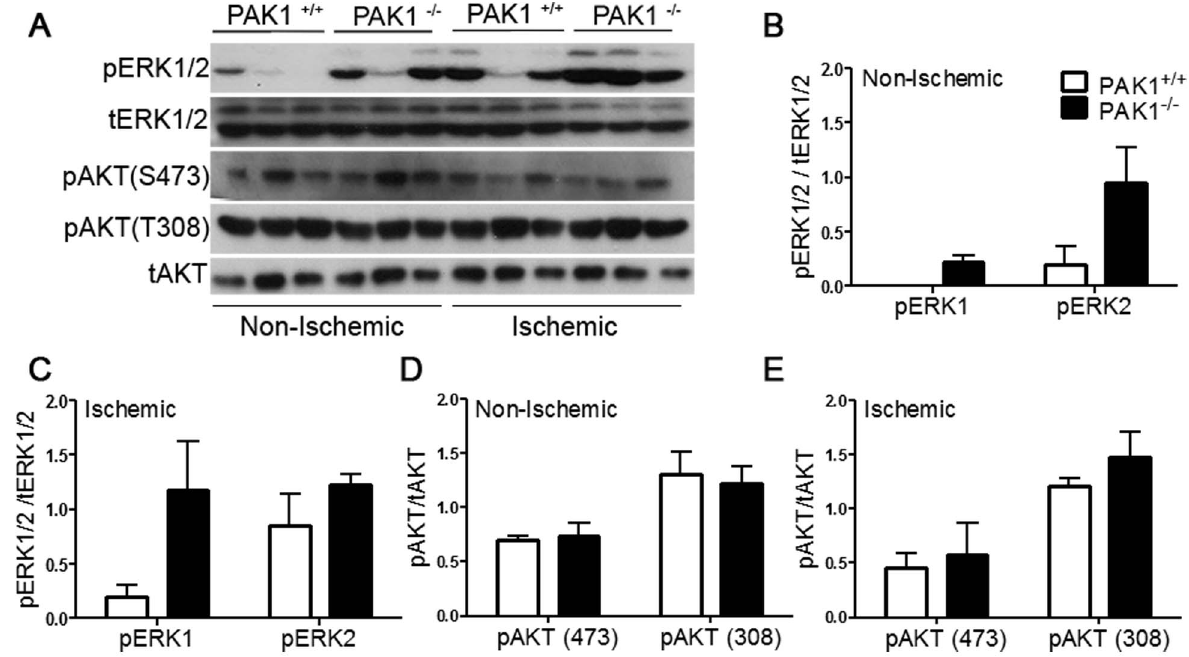
Figure 4. A) A notable activation of ERK1/2 but not AKT is observed in PAK1 2 / 2 gastrocnemius tissue one hour after HLI surgery. Western blotting analysis of PAK1 2 / 2 non-ischemic and ischemic gastrocnemius muscle shows enhanced phosphorylation of ERK1/2 on Thr202/Tyr204 compared to PAK1 + / + tissue, whereas phosphorylation of AKT was unchanged. Lanes are grouped into Non-Ischemic and Ischemic from either PAK1 + / + and PAK1 2 / 2 mice. B and D) Densitometric analysis of non-ischemic tissue from PAK1 + / + and PAK1 2 / 2 show an increase in pERK1/2 activation (p=0.03 and 0.06 for pERK1 and pERK2 respectively, Student’s T-test) whereas a difference in pAKT activation is not observed. C and E) In ischemic tissue a trend towards an increase in pERK1 (p=0.08, Student’s T-test) but not pERK2 or pAKT in PAK1 2 / 2 compared to control PAK1 + / + was observed. A total of 3 PAK1 + / + and PAK1 2 / 2 mice were analyzed. Blots for pERK1/2 and pAKT were normalized to tERK1/2 and tAKT respectively.